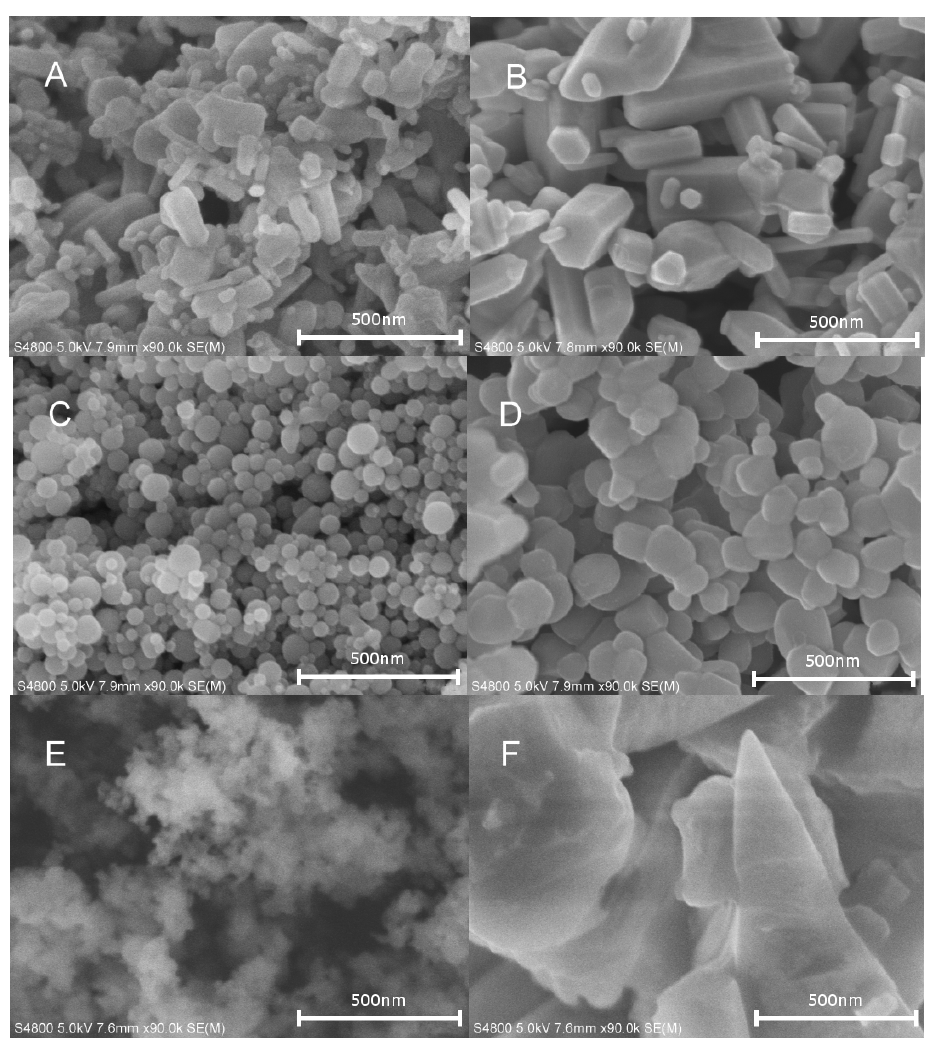
Figure 1. Scanning electron microscope (SEM) images of ( A ) Rh/nano-ZnO; ( B ) Rh/ZnO; ( C ) Rh/nano-TiO ; ( D ) Rh/TiO ; ( E ) Rh/nano-SiO 2 2 catalysis reaction.